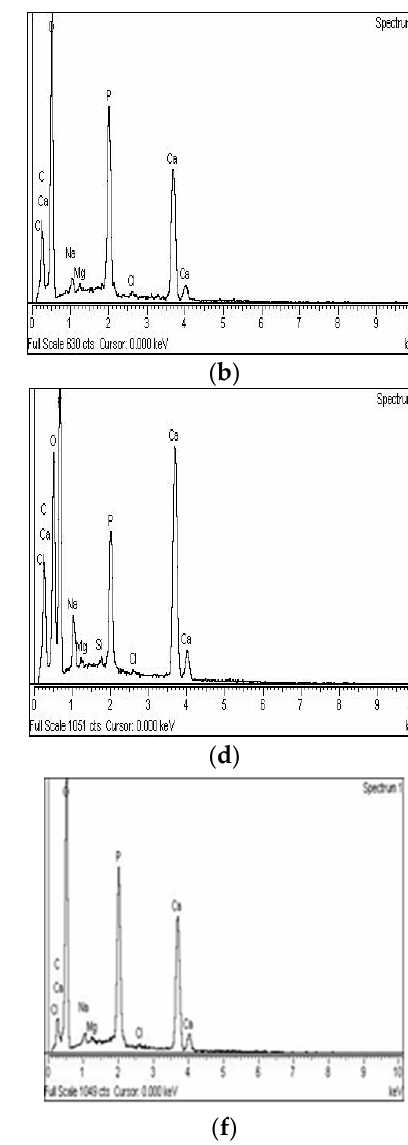
Figure 2. Representative SEM images (accelerating voltage of 5 kV, working distance of 10 mm, magnification of 500×) of the sample surfaces after remineralization.